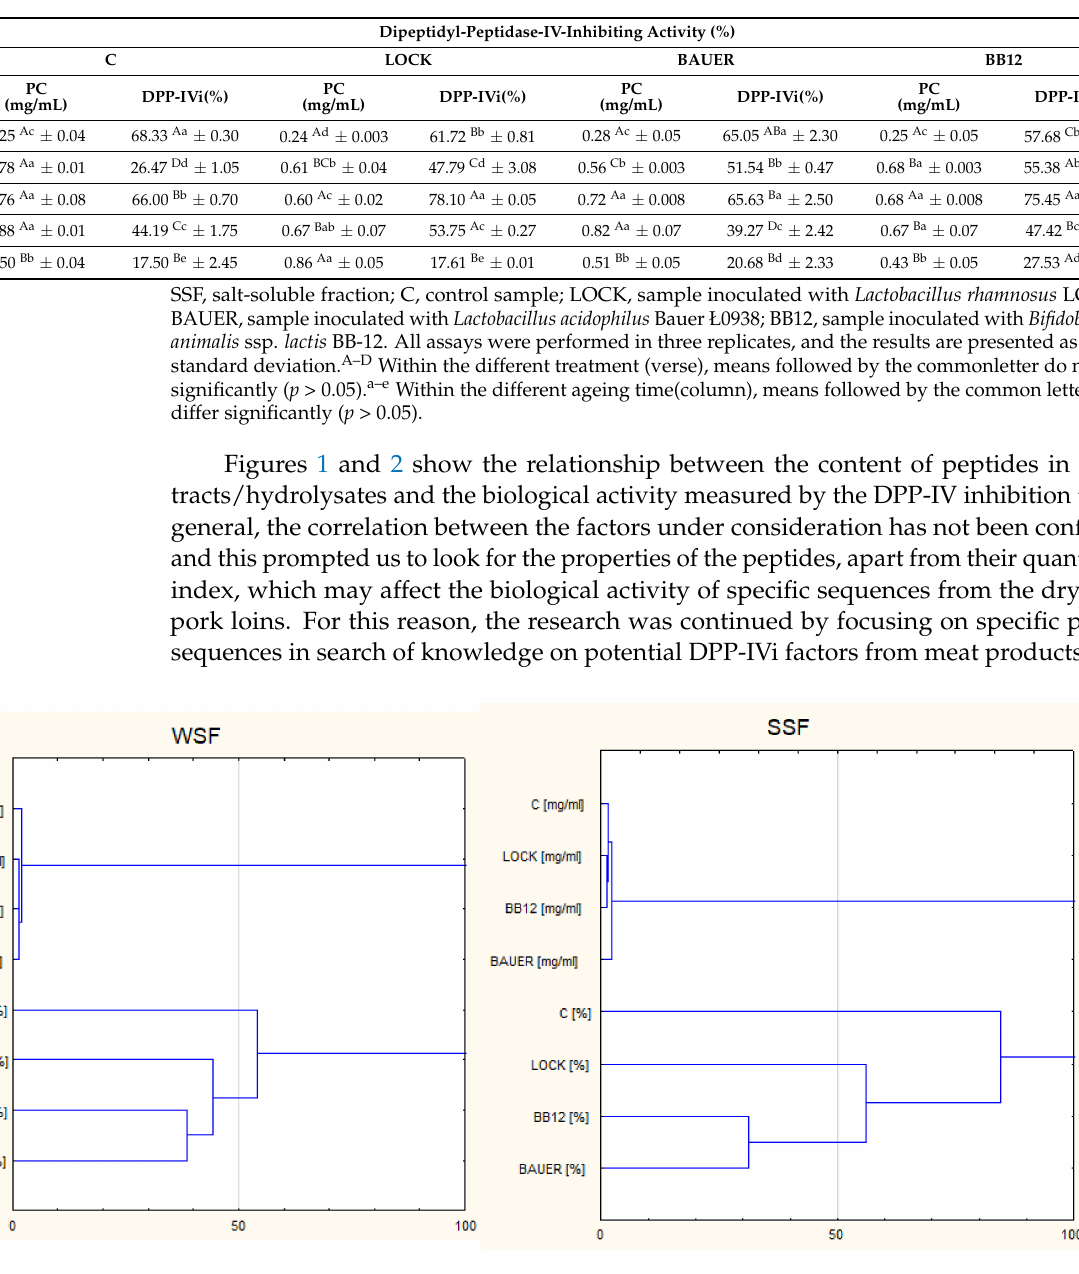
Figure 1. Dendrogram resulting from the Ward’s method of hierarchical cluster analysis of peptides (>7 kDa)concentration (mg/mL) and DPP-IV-inhibiting activity (%) in analyzed fractions WSF, water-soluble fraction; SSF, salt-soluble fraction; C, control sample; LOCK, sample inoculated with Lactobacillus rhamnosus LOCK900; BAUER, sample inoculated with Lactobacillus acidophilus Bauer Ł0938; BB12, sample inoculated with Bifidobacterium animalis ssp. lactis